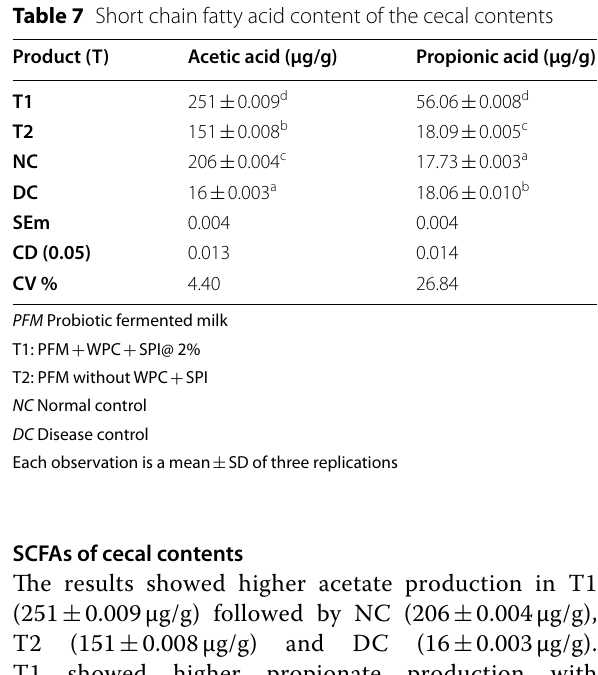
Table 7 Short chain fatty acid content of the cecal contents